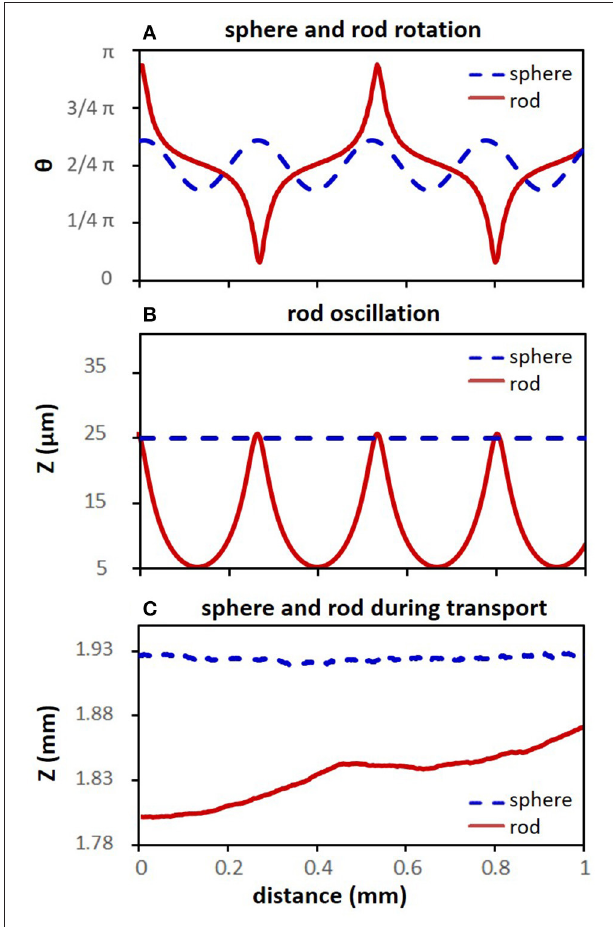
FIGURE 2 | Simulated particle trajectories for both 1 µ m spheres and their equivalent volume rod particles of aspect ratio 6 from parallel plate geometry Dimension I, under pore water velocity 5 m/day, with all external forces and Brownian motions ignored except for (C) , in which all mechanisms were included. (A) Euler angle θ vs. distance for sphere and rod. (B) Particle center position in z-direction vs. distance for a single representative sphere and rod. (C) Particle center position in z-direction vs. distance for a single representative sphere and rod under normal simulation conditions (all mechanisms